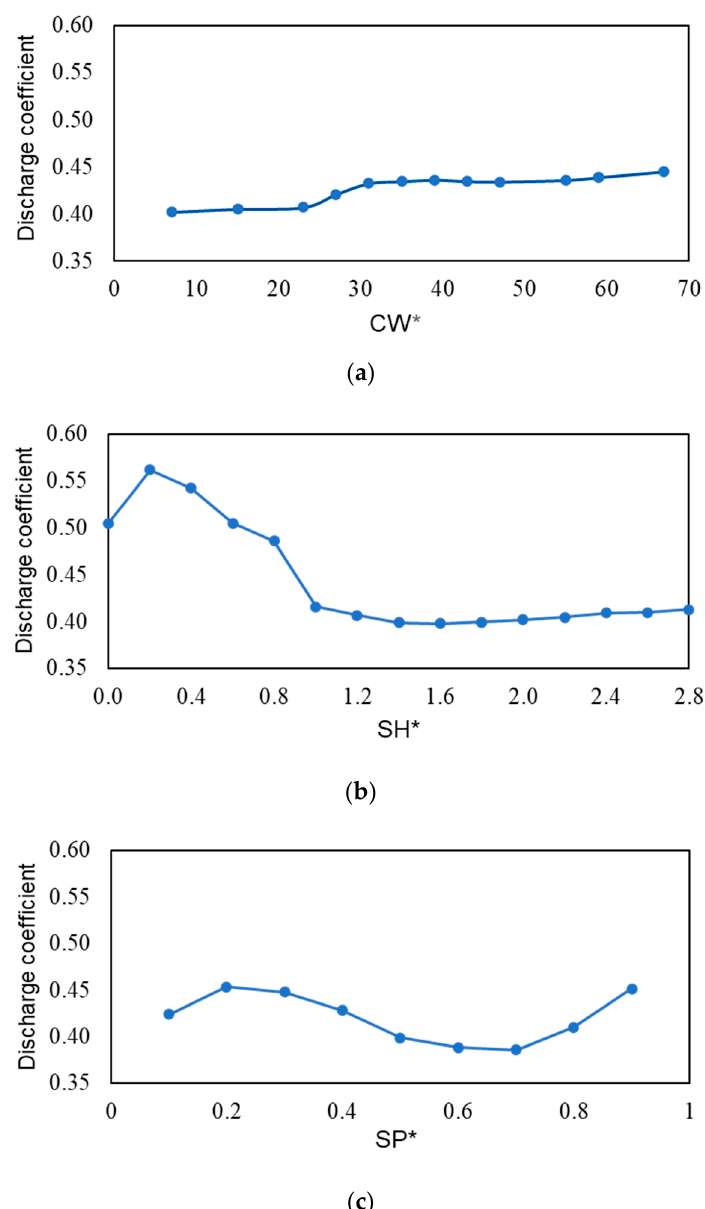
Figure 6. Prediction of the discharge coefficient according to the changes in the turbulence model discharge coefficient using geometrical parameters. ( a ) CW*. ( b ) SH*. ( c ) SP*.